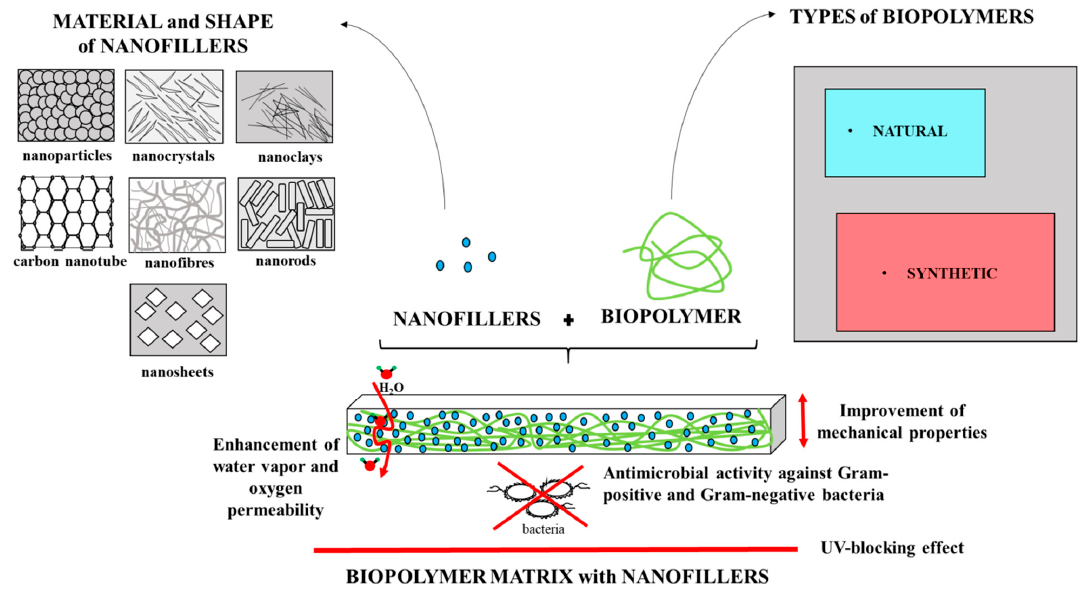
Figure 1. Schematic preparation of nanocomposite films and their functional properties.